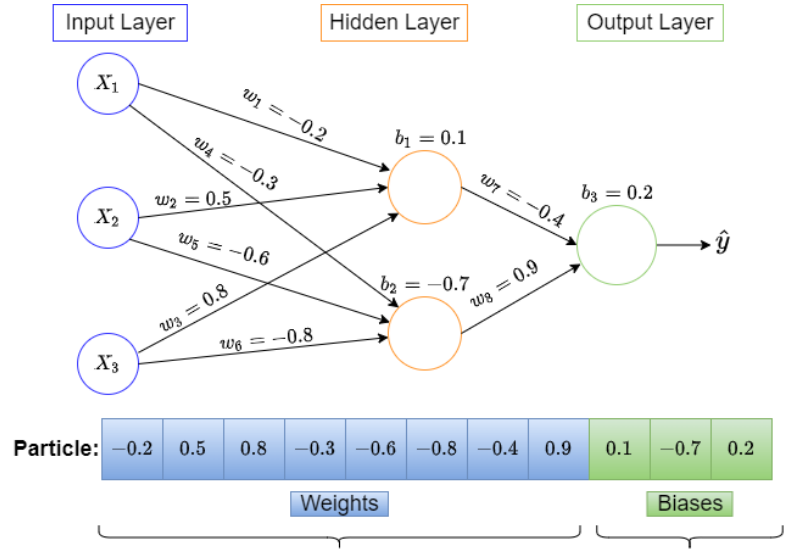
Figure A1. Encoding the MLP weights and biases in a particle.